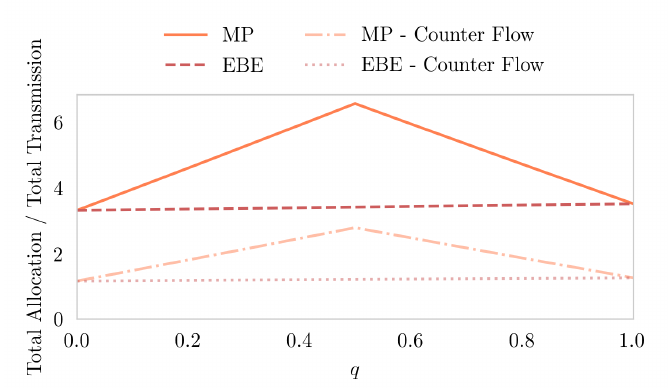
Figure 7. Total allocated flow of an exemplary snapshot in the network for both allocation methods, MP and EBEs, as a function of the shift parameter q . Whereas q = 0 and q = 1 result in the same allocation, the MP algorithm allocates more counter-flows as q further approximates to q = 0.5 (the standard MP setup), which is due to a strong increase of counter